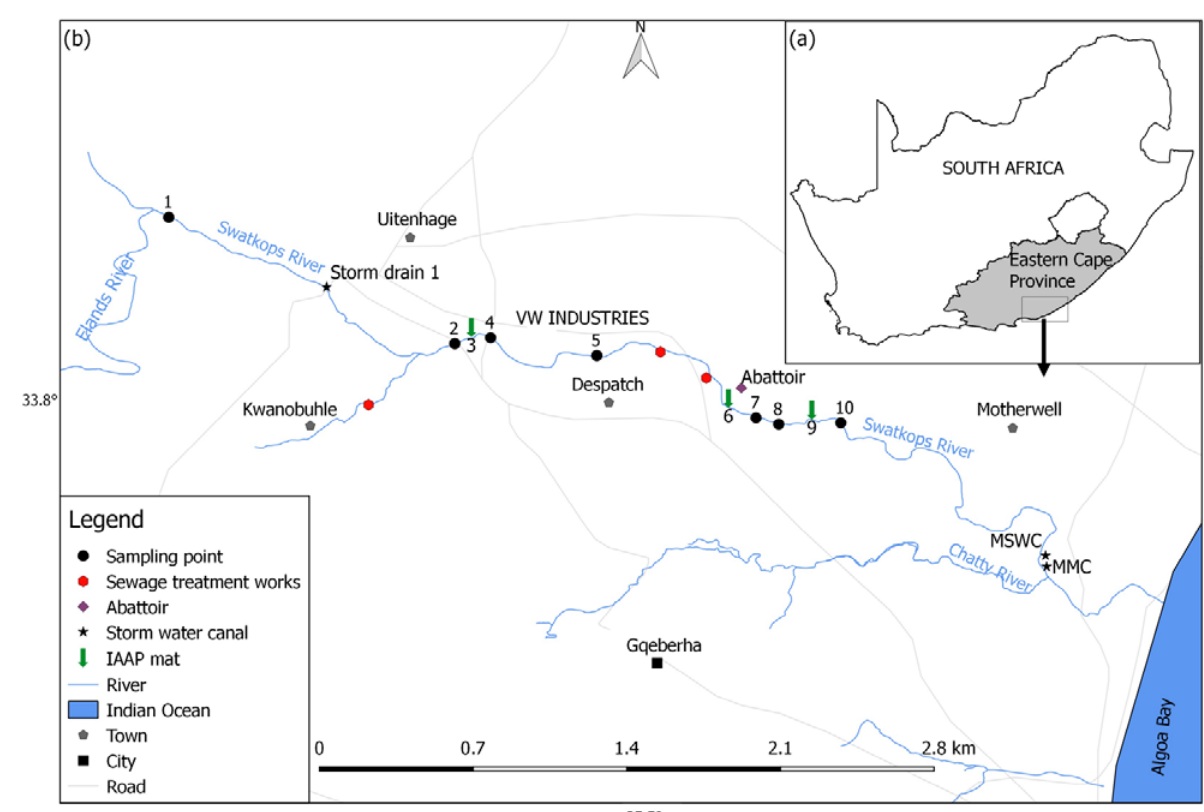
Figure 1. The South African map insert ( a ) the Swartkops River and tributaries showing 10 sampling locations and land-use activities along the river system ( b ) Motherwell Storm Canal (MWSC) and Markman Canal (MMC).